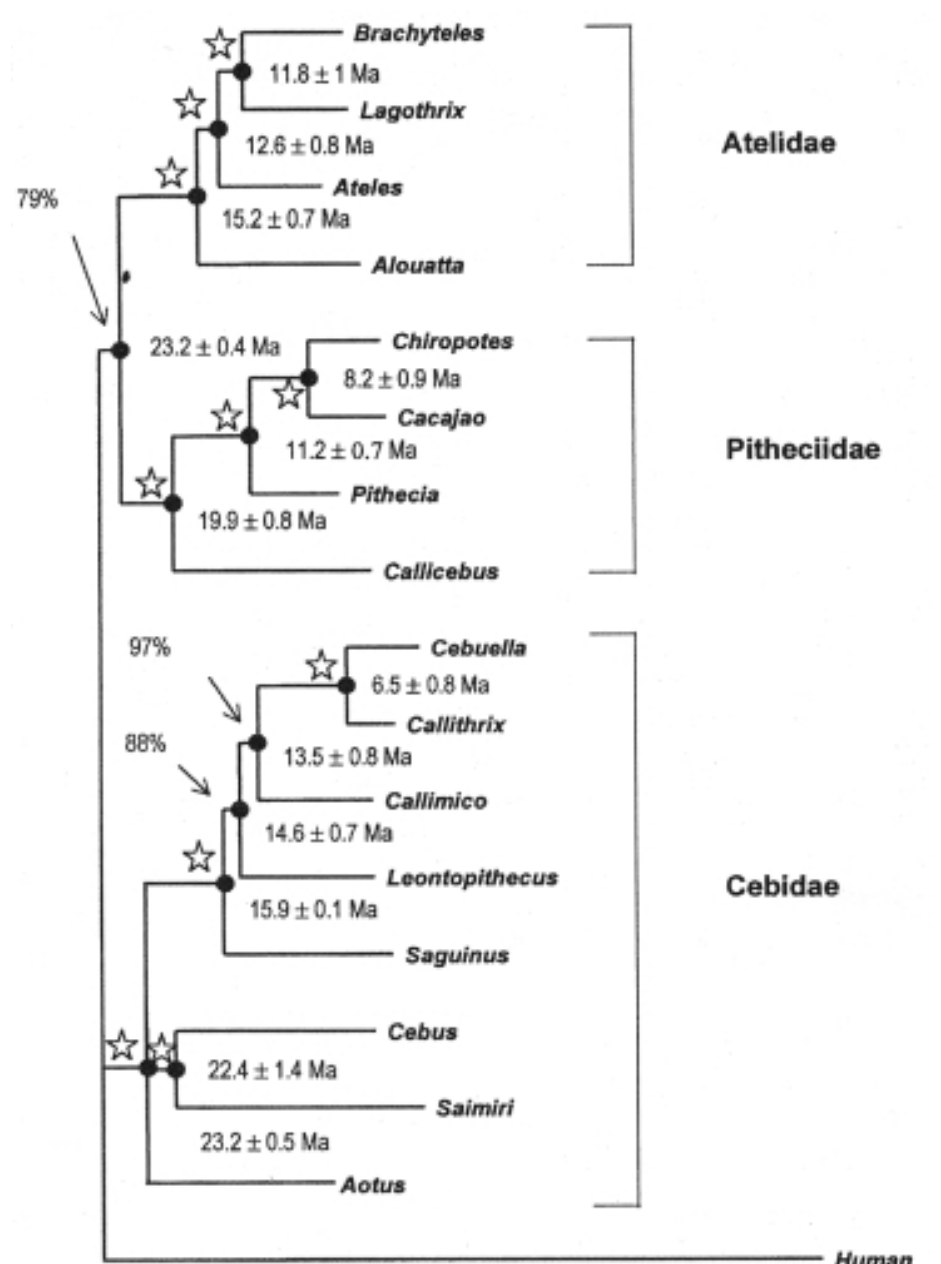
Fig. 1 – Phylogenetic tree found for the 17 sequences of the β 2-M, EPSILON, G6PD and IRBP genes aligned in tandem. Branch lengths and standard deviations were estimated based on least- squares method described in Takezaki et al . (1995). Divergence times were estimated using the local molecular clock strategy as described in Schneider et al . (1993). MP Bootstrap values at the nodes were obtained in 1000 replicates. Stars at nodes means BS of 99-100%. The length and Consistency index of the MP tree was 2855 and 0.83, respectively.